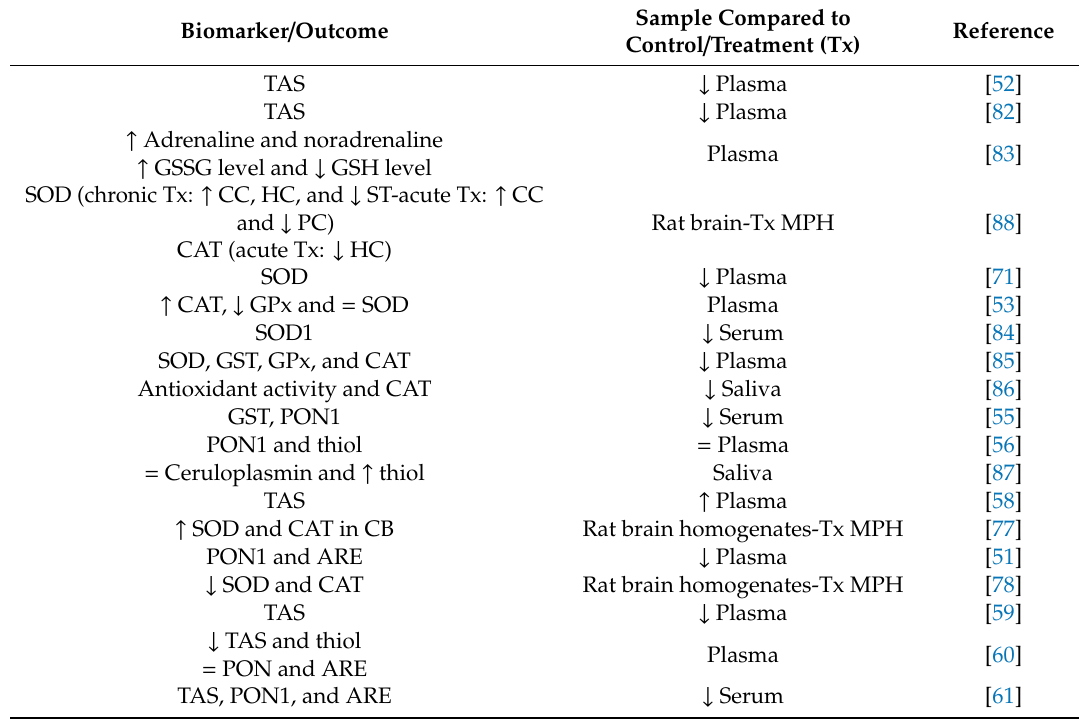
Table 2. Summary of antioxidant biomarkers and